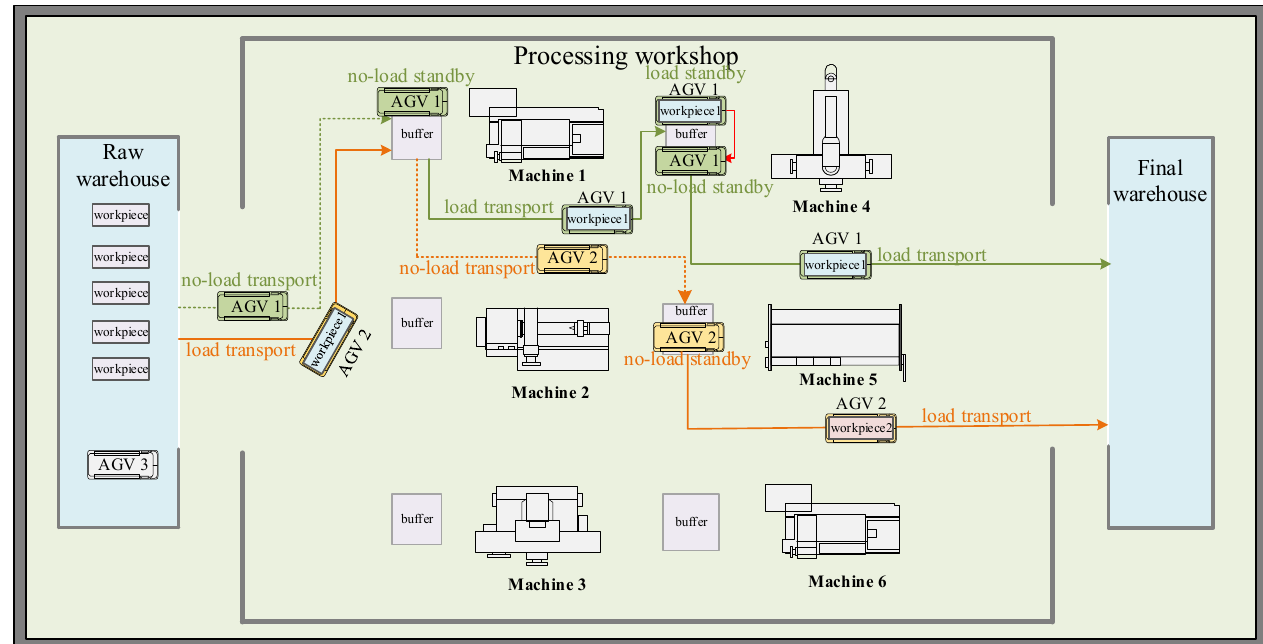
Figure 1. The working layout of the workshop in the investigated enterprise.